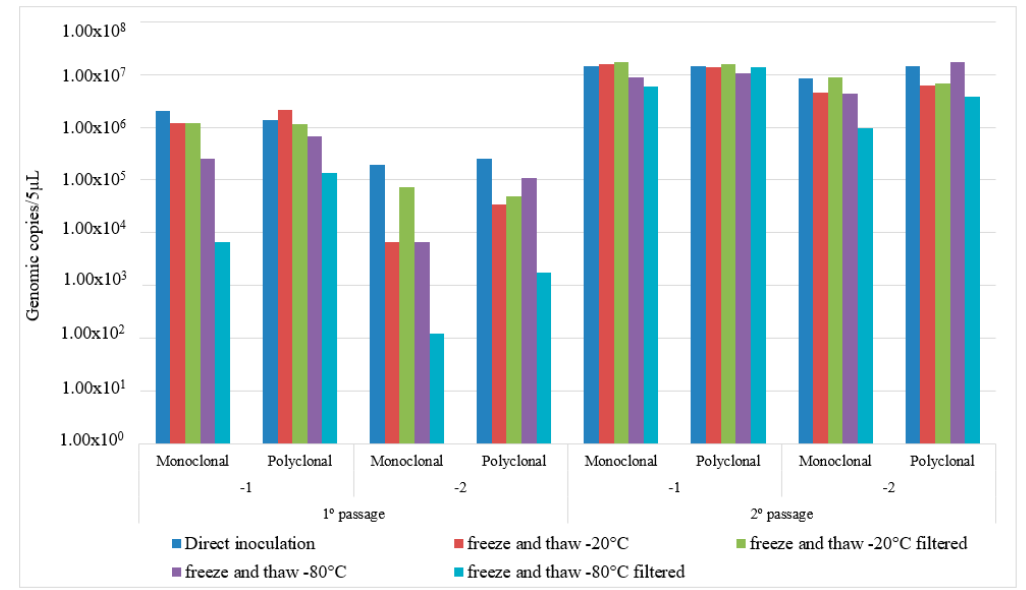
Figure 5. Detection of viral infectious particles in HAdV-5 serial dilution samples concentrated by the IMS method.